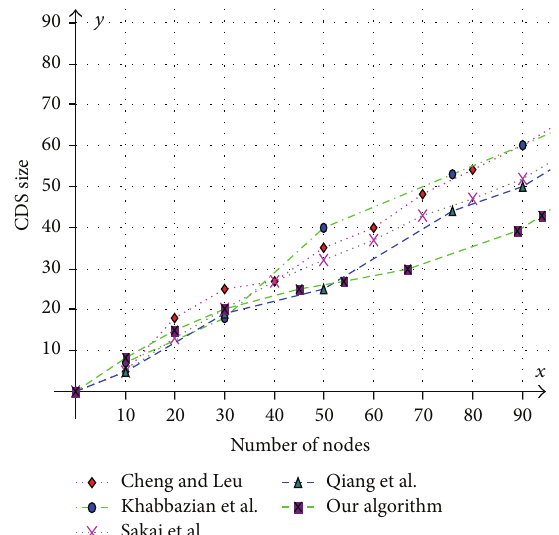
Figure 9: Number of nodes versus CDS size (transmission range = 25 mts and speed =